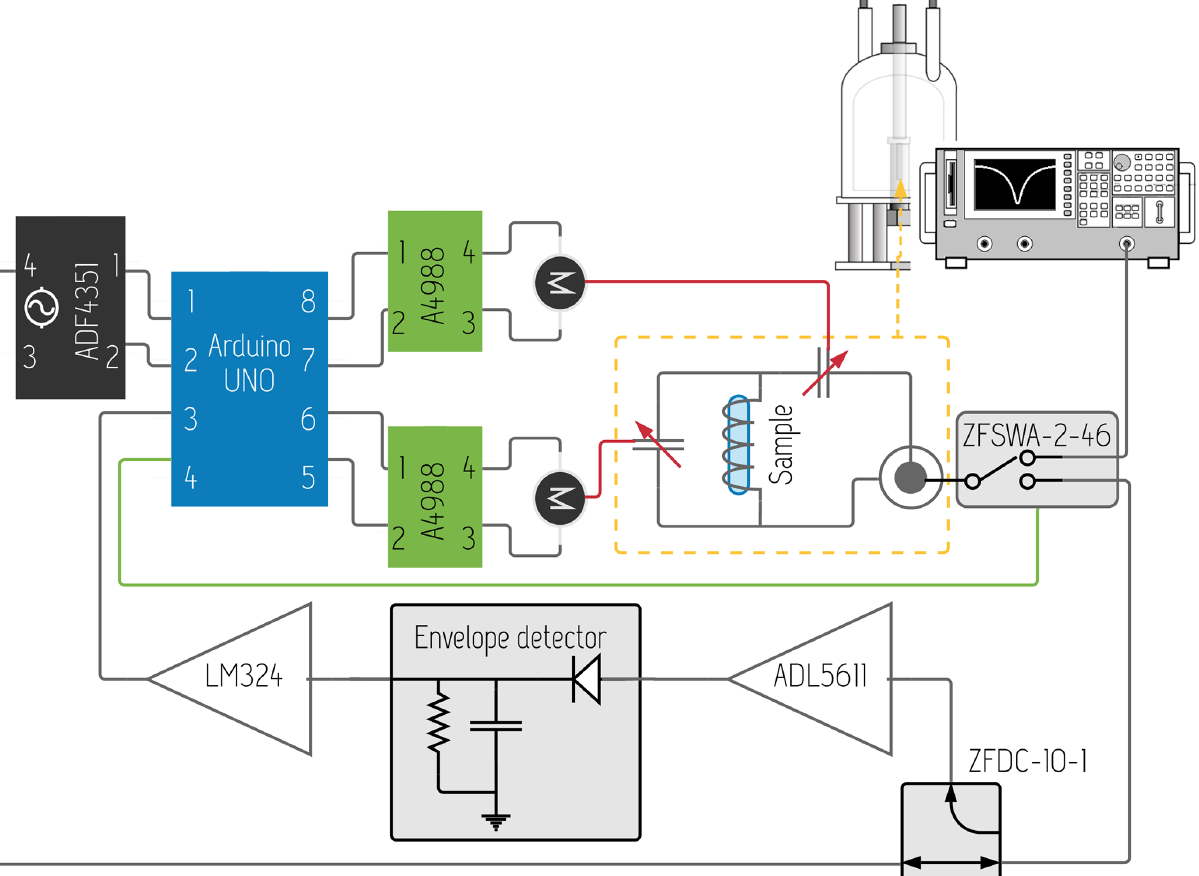
Figure 3. Block diagram of the ArduiTaM, detailing its component interconnections, as well as how the system can be inserted into the signal path of a